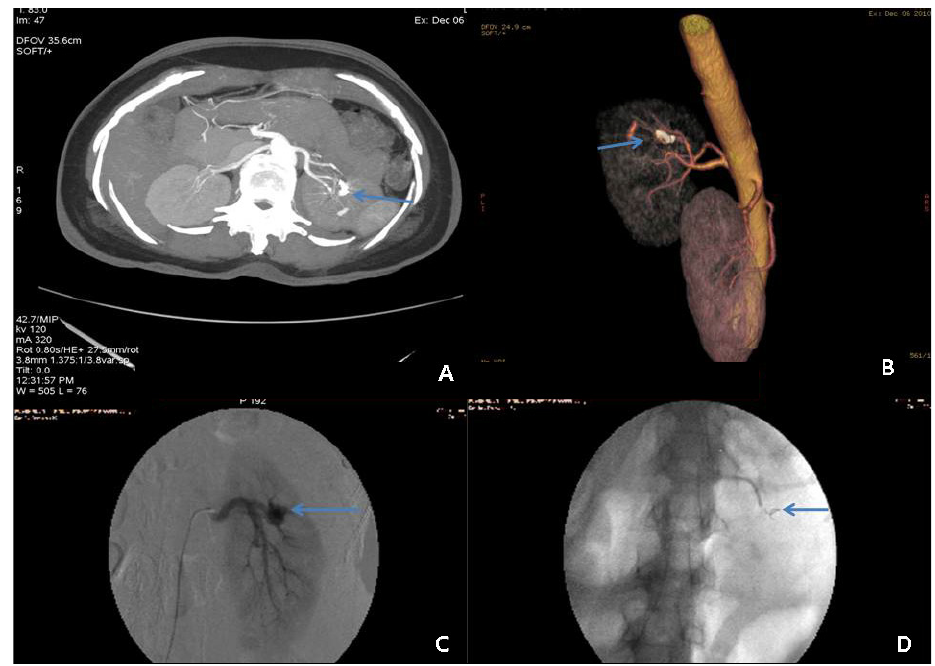
Figure 3. Case 3. a and b ) Axial cuts and lateral MIP images showing AV fistula in a branch of the posterior segmental artery. Arrow shows the location of AV fistula. c ) Conventional angiography confirms the presence of AV malformation in the branch of the posterior segmental. Arrow shows the location of AV fistula on CA. d ). Successful embolisation. Arrow shows the position of the coil.